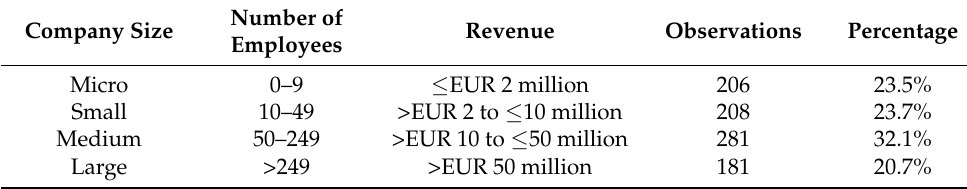
Table 1. Sample composition by company size (n =